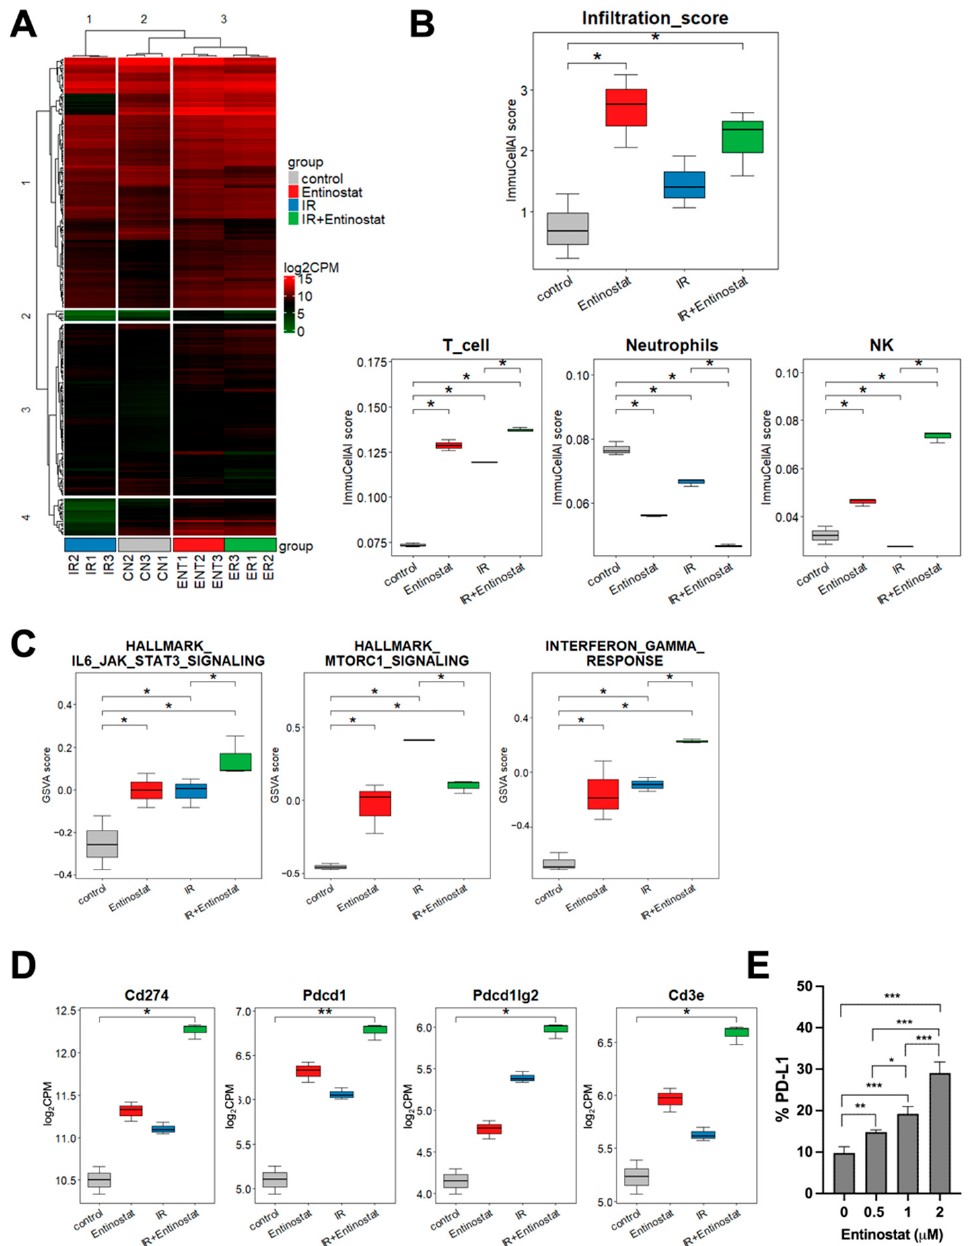
Figure 4. Transcriptomic analysis reveals entinostat-mediated immune modulation in the tumor microenvironment. ( A ) Heatmap representing hierarchical clustering of all DEGs in four groups. ( B ) ImmuCellAI-mouse based estimation of immune cells infiltrating in tumors. ( C ) Comparison of GSVA scores of IL6-JAK-STAT3, mTORC1, and IFN- γ signaling pathways among three groups. ( D ) Comparison of expression levels of PD-1 pathway genes. ** p < 0.01, * p < 0.05. ( E ) Entinostat induces PD-L1 in LL/2 cells. Dose-dependent induction of PD-L1 in LL/2 cell, which was assessed by flow cytometry. * p < 0.05, ** p < 0.01, *** p < 0.001.